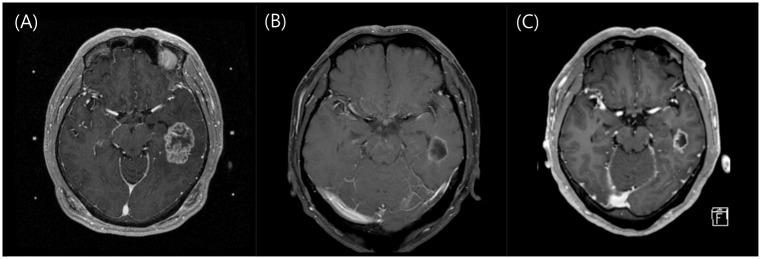
Another illustrative case of fractionated radiosurgery for large brain metastases.(A) A 53-year-old man was diagnosed with brain metastases on a staging work-up for non-small cell lung cancer. The lesion was 24.1 cm3; radiosurgery was performed with a marginal dose of 8 Gy targeted to the 50% isodose line in 3 consecutive daily fractions. The patient was also started on Gefitnib chemotherapy. (B) After 1 month, the lesion dramatically decreased to 4.9 cm3. (C) After 3 months, the lesion decreased to 3.4 cm3. The patient was later diagnosed with leptomeningeal carcinomatosis and was on Erlotinib chemotherapy at the time of analysis, which was 8 months after SRS.